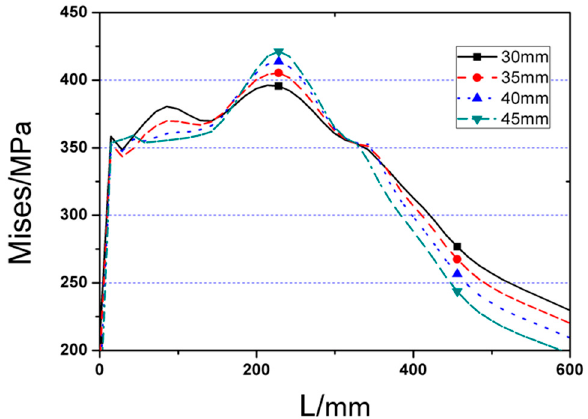
Figure 18. The Von Mises stress distributions along beam length (start from steel tube) of RC series FE joint models.